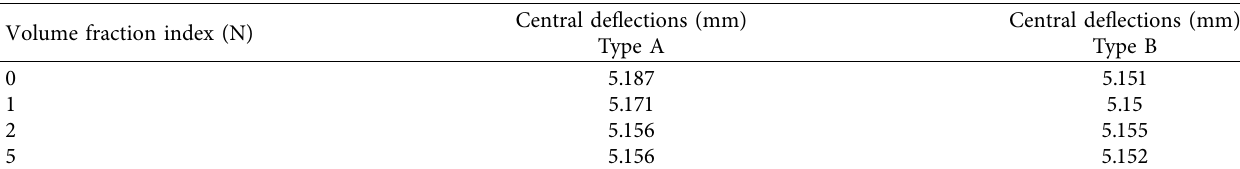
Table 9: Central deflections of the plates with different volume fraction indexes.